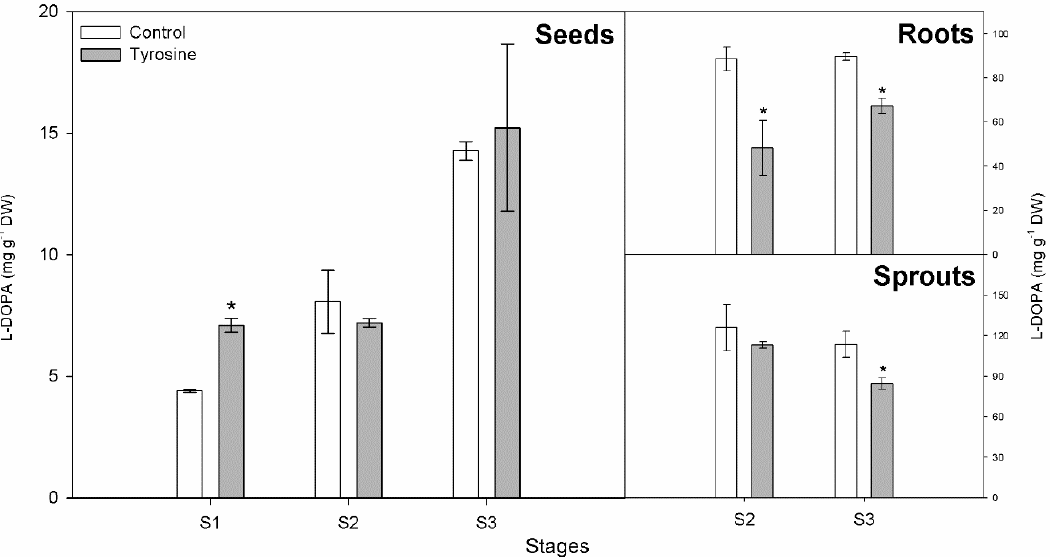
Figure 1. Effect of tyrosine treatment on Levo-3,4-dihydroxyphenylalanine (L-DOPA) content in Vicia faba seeds, roots, and sprouts at the early stages of development: S1: 3 – 4 days, S2: 8 – 9 days, and S3: 2 – 4 leaves. The bars indicate ± standard error ( n = 3). * indicates significant differences between controls and tyrosine treatments according to Tukey ( P < 0.05).